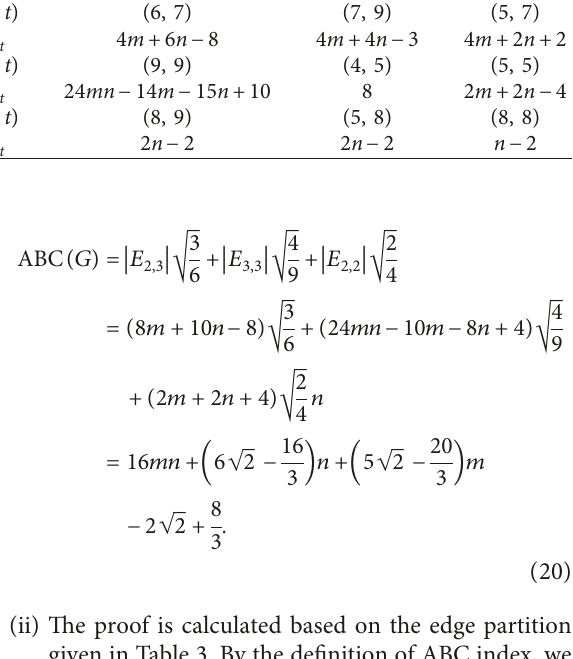
Table 2: Partition of the edge set of VC